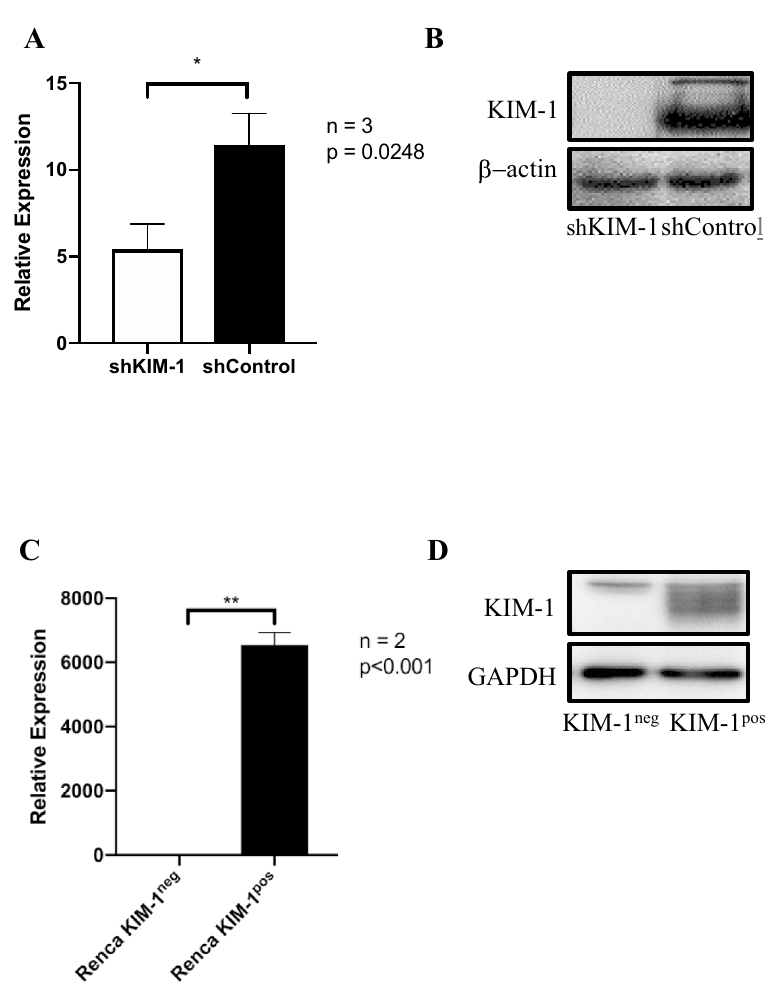
Figure 1. Knockdown of human KIM-1 in 786-O cells and expression if murine KIM-1 in Renca RCC cells. ( A ) 786-O cell lines were transduced using lentivirus encoding either KIM-1 shRNA or a control shRNA plasmid. RT-qPCR of 786-O cell lines normalized to housekeeping gene (GAPDH), showing successful knockdown of KIM-1 mRNA in 786-O-shKIM-1, but not in 786-O-shControl (*p = 0.0248). ( B ) Western Blot analyses confirming KIM-1 protein knockdown in 786-O-shKIM-1, but not 786-O-shControl cell lines. ( C ) Renca cell lines were transduced using lentivirus encoding either KIM-1 expressing (KIM-1 pos ) or non- expressing (KIM-1 neg ) vectors. RT-qPCR of Renca cell lines normalized to housekeeping gene (GAPDH), showing successful upregulation of KIM-1 in Renca KIM-1 pos , but not Renca KIM-1 neg cell lines (**p < 0.001). ( D ) Western blot analyses confirming strong cellular KIM-1 protein expression in Renca KIM-1 pos , but not in Renca KIM-1 neg cell lines. The cropped Western blots images in ( A ) and ( B ) were obtained from the same gel but the resulting membranes were cut and probed with either anti-KIM-1 or anti-GAPDH antibodies for ( A ). The exposures was optimized by the digital imaging